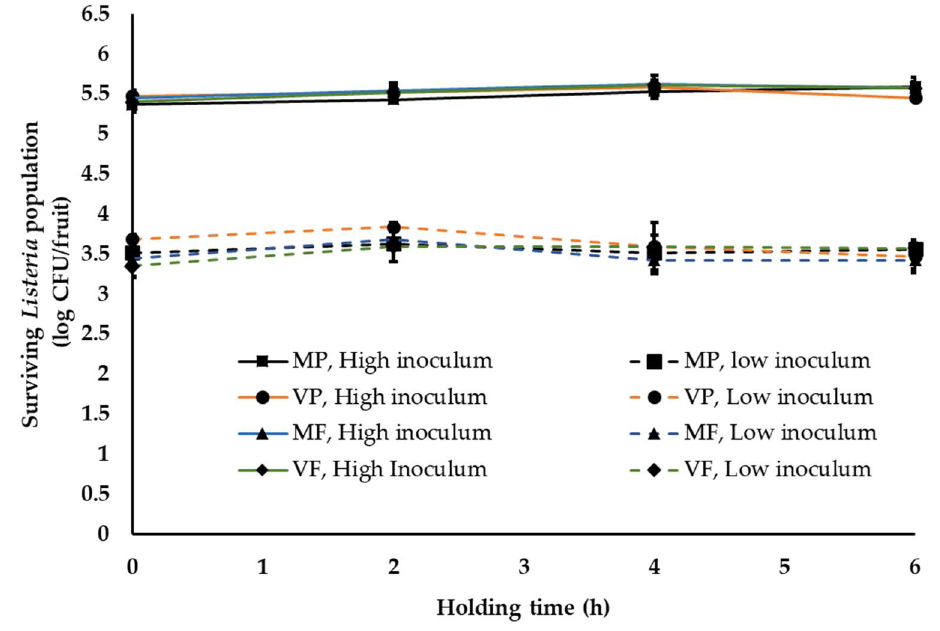
Figure 3. Listeria survival on peaches following fruit waxing and fungicide application under simulated packinghouse conditions (temperature—28–30 °C (ambient warm season temperature), RH—40–50% (ambient humidity) and holding time—1 to 6 h) at high (~5 log CFU/fruit) and low (~3 log CFU/fruit) pathogen load. Fruit finish formulations used in the study include MP, mineral oil + propiconazole; VP, vegetable oil + propiconazole; MF, mineral oil + fludioxonil; and VF, vegetable oil + fludioxonil. Data are represented as the mean ±